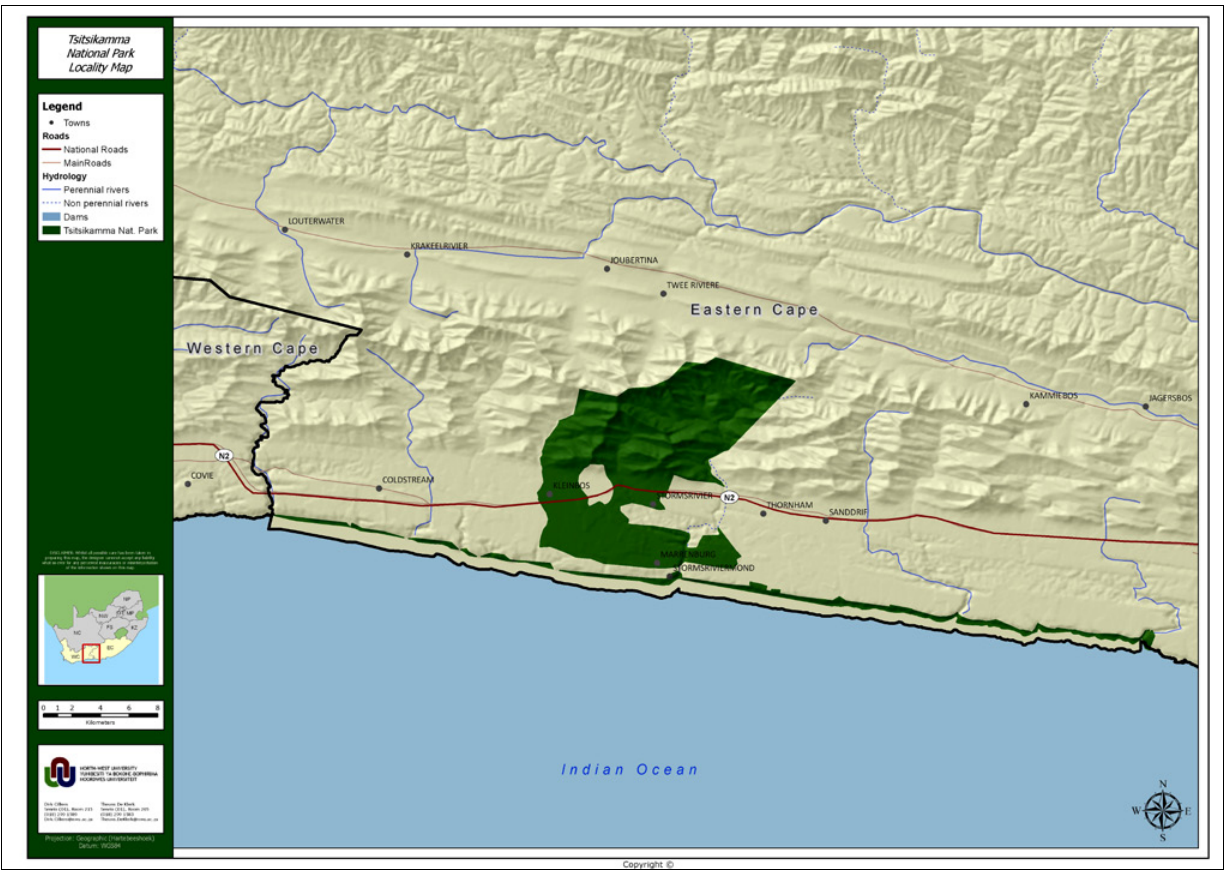
FIGURE 1 Location of Tsitsikamma National